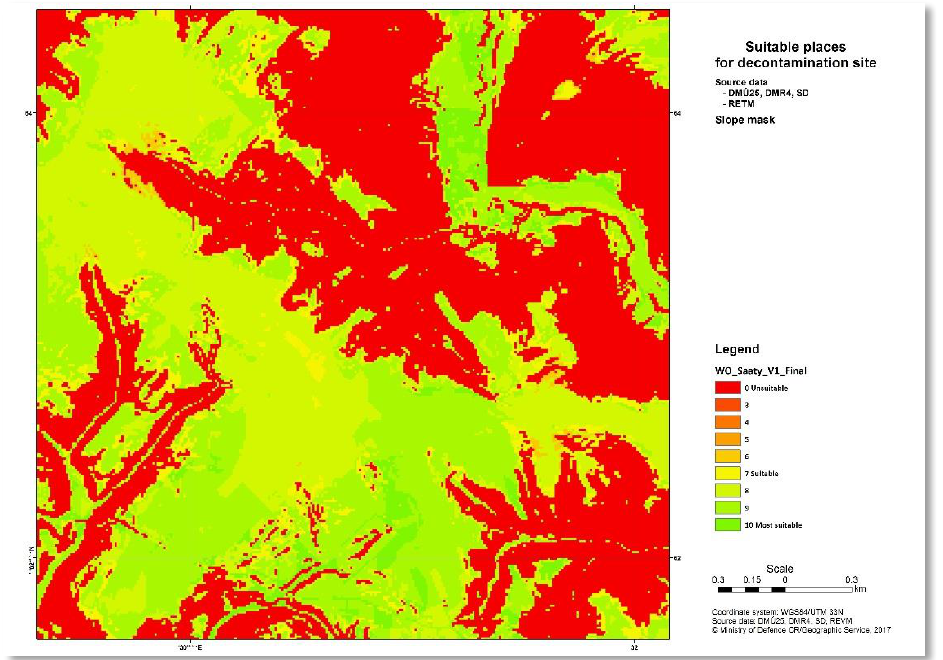
Figure 6. Final cost map of landscape potential for DS deployment in detail.